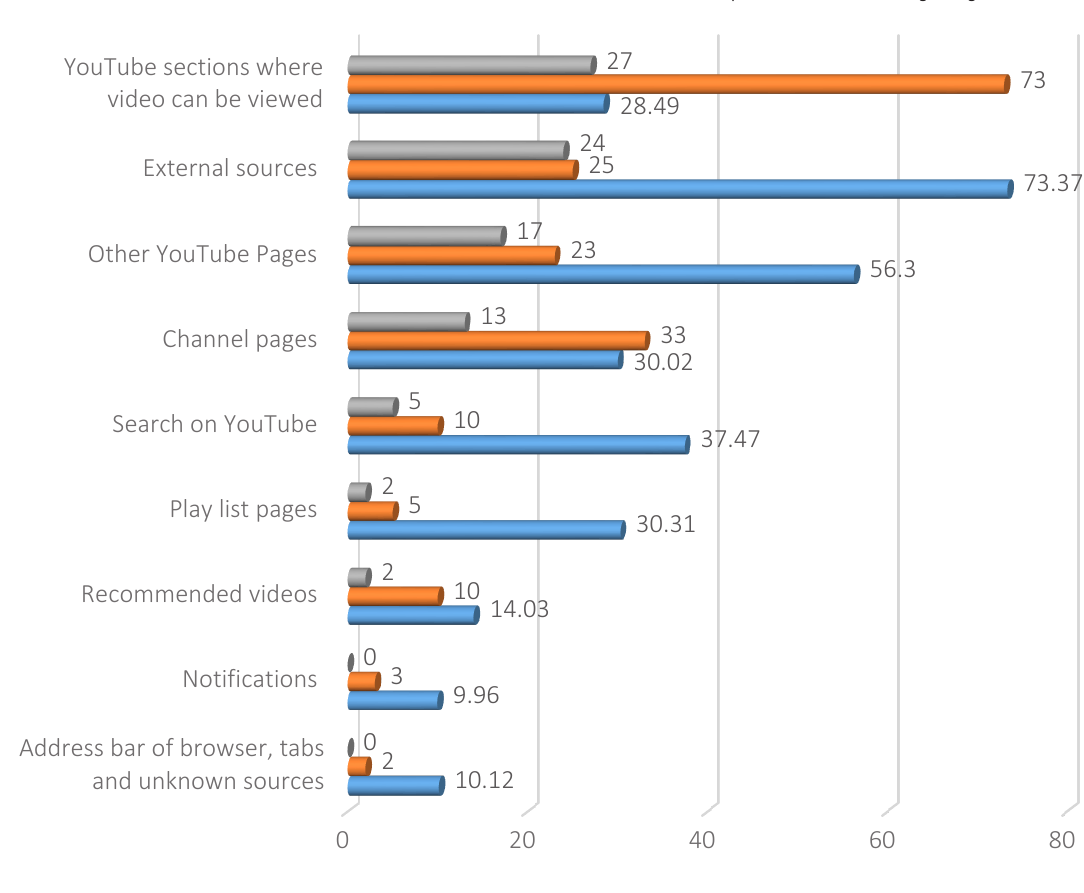
Figure 10. Analysis of video clip views during 21